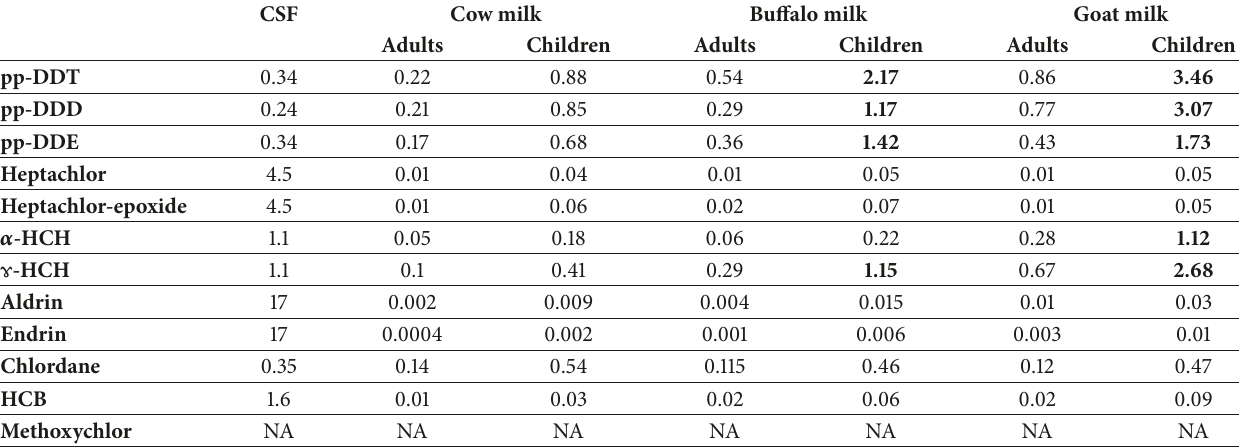
Table 3: Cancer hazard ratio among Egyptian population due to ingestion of OCPs-contaminated milk from different animal species. CSF Cow milk Buffalo milk Goat milk Adults Children Adults Children Adults